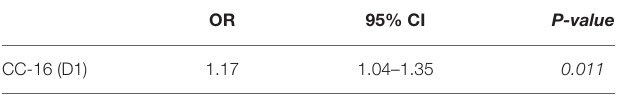
TABLE 6 | Risk for death: Multivariate